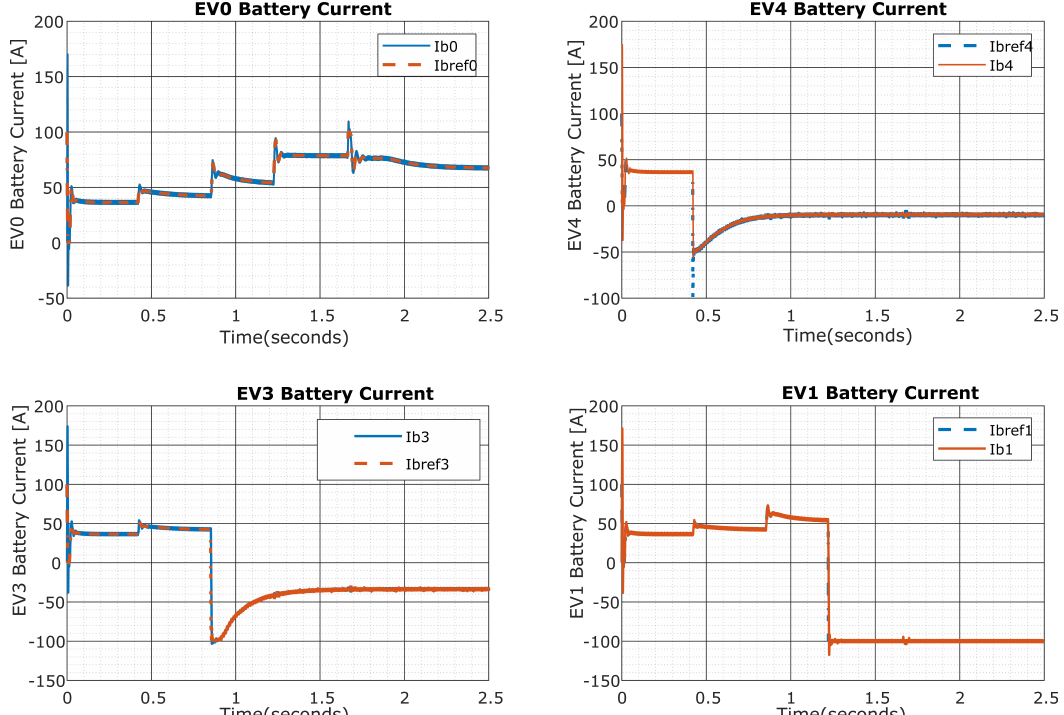
Figure 16. Battery current controls in Mode 1 and Mode 2 [21], © 2021